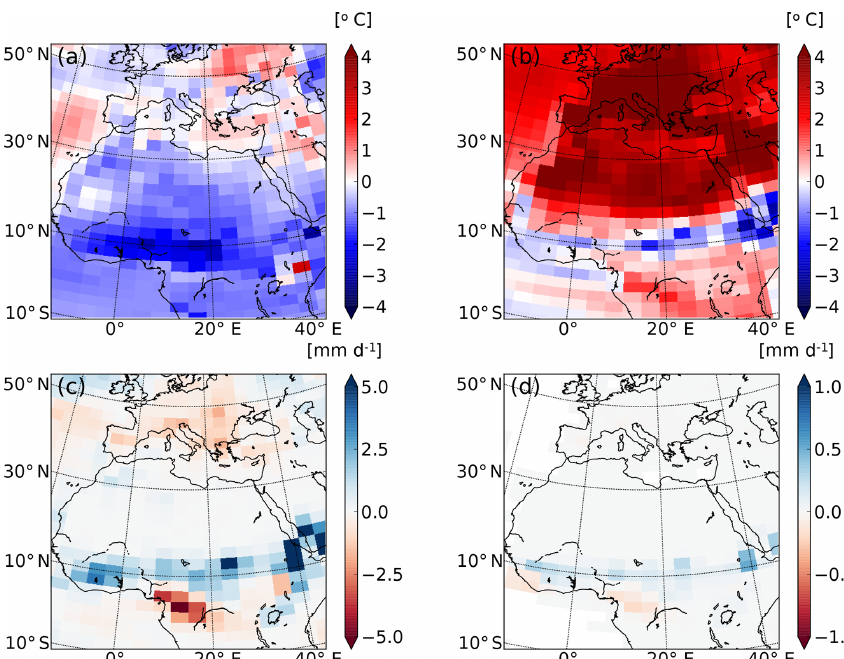
Figure 7. Temperature and precipitation deviations of EHOL from PICTRL in LMDZ-global, the AGCM for (a) winter surface air tempera- tures at 2m, (b) summer surface air temperatures at 2m, (c) June to August precipitation and (d) July to September surface runoff (averaged over the entire simulation).